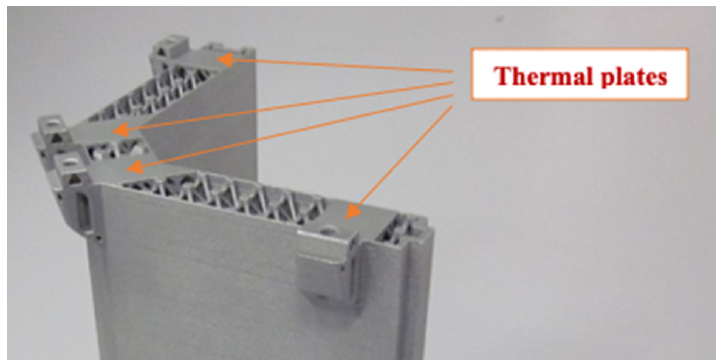
Figure 7. Thermal plates for allow the heat transfer between stacked structures.